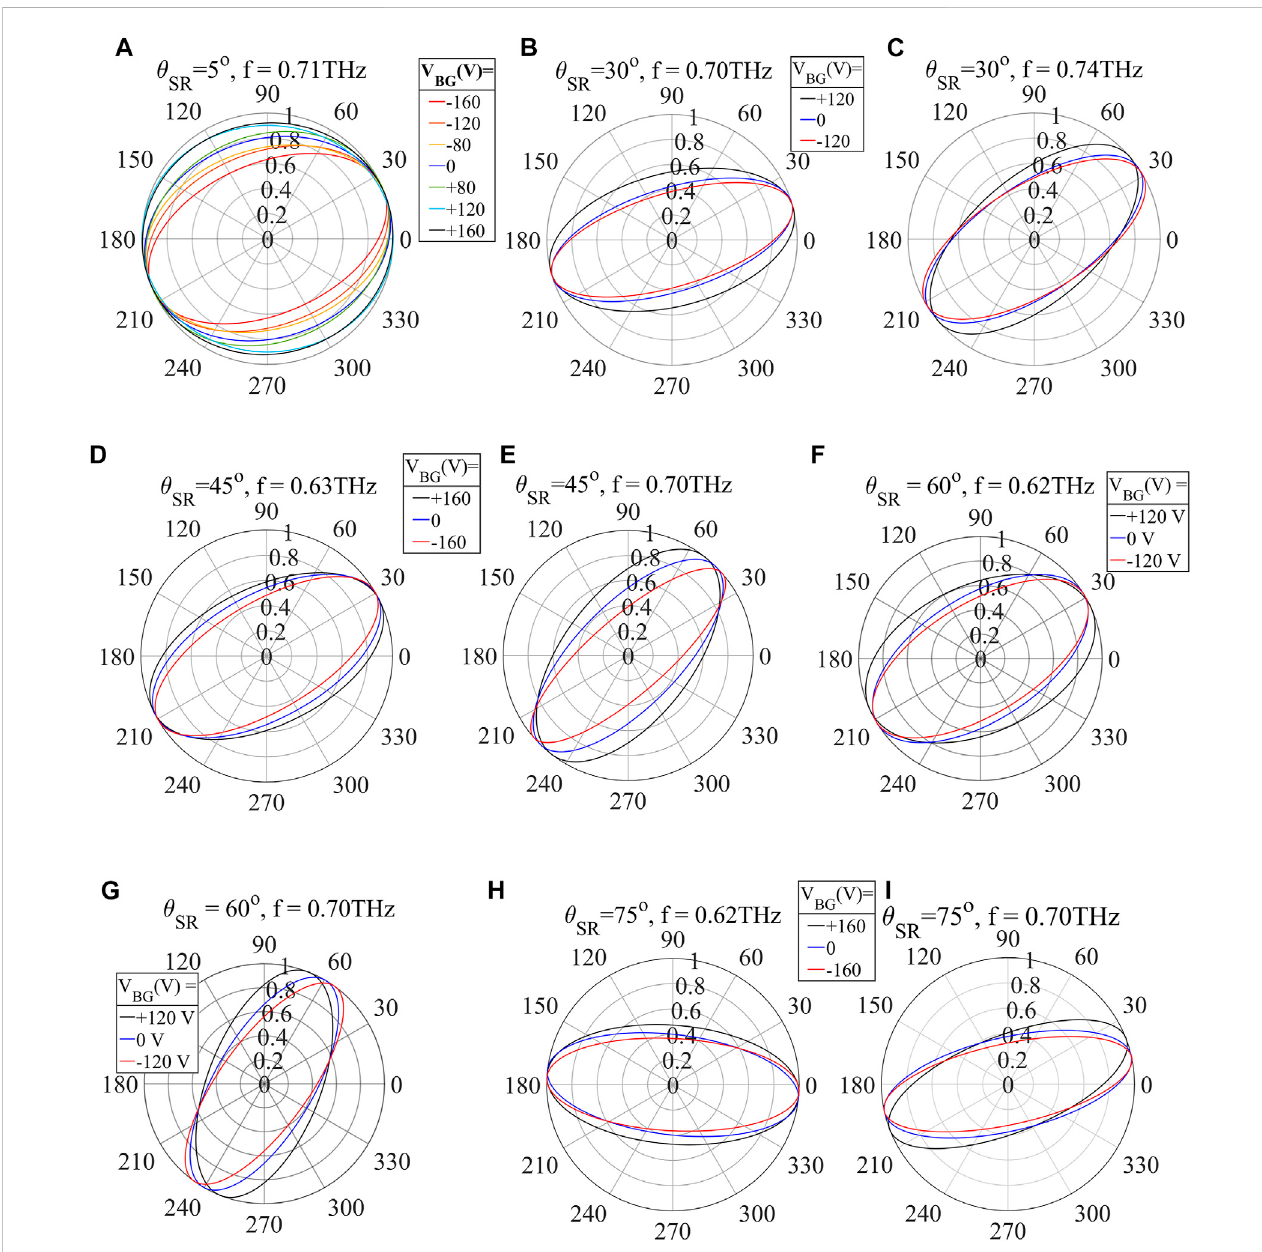
FIGURE 9 (A – I) Polarization ellipses for different SRs angles considering all transmitted temporal